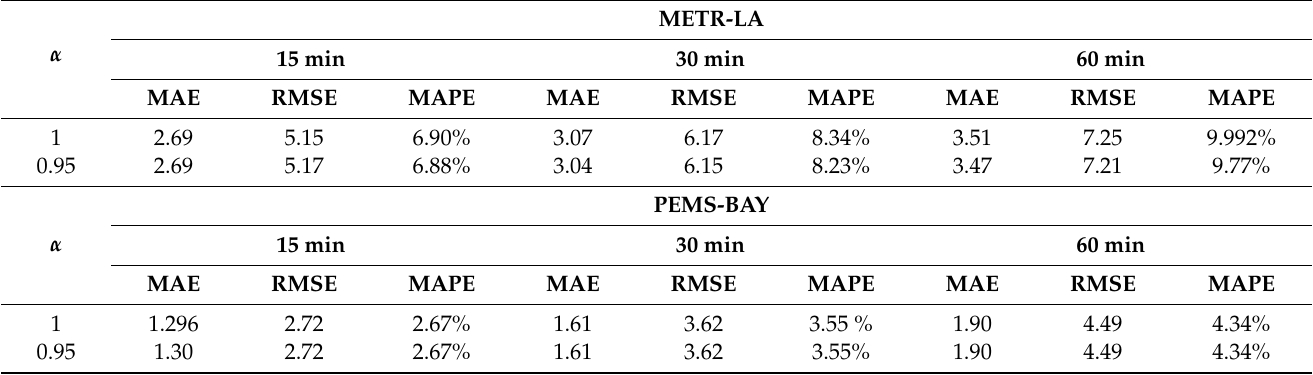
Figure 4. Variation of error for different α on two datasets: ( a ) the experimental errors corresponding to different α values on the METR-LA dataset; ( b ) the experimental errors corresponding to different α values on the PEMS-BAY dataset. Table 2. Experimental results of α on METR-LA and